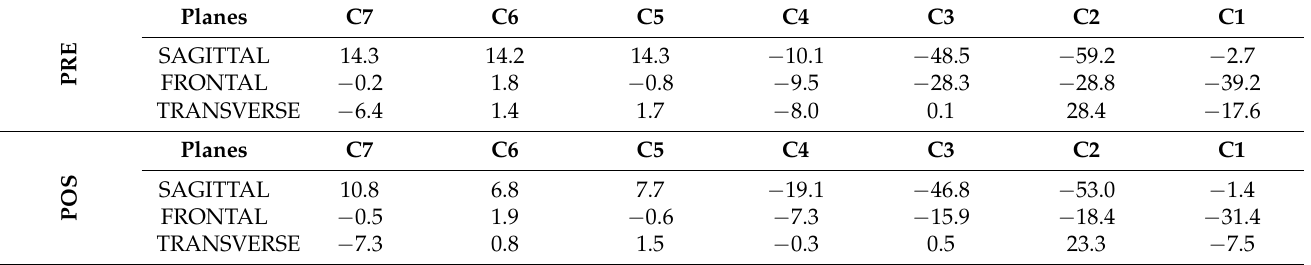
Table 1. Pre- (PRE) and post-operative (POS) relative orientations of the cervical vertebrae calculated with respect to T1-based anatomical reference frame in PLA-VIR and